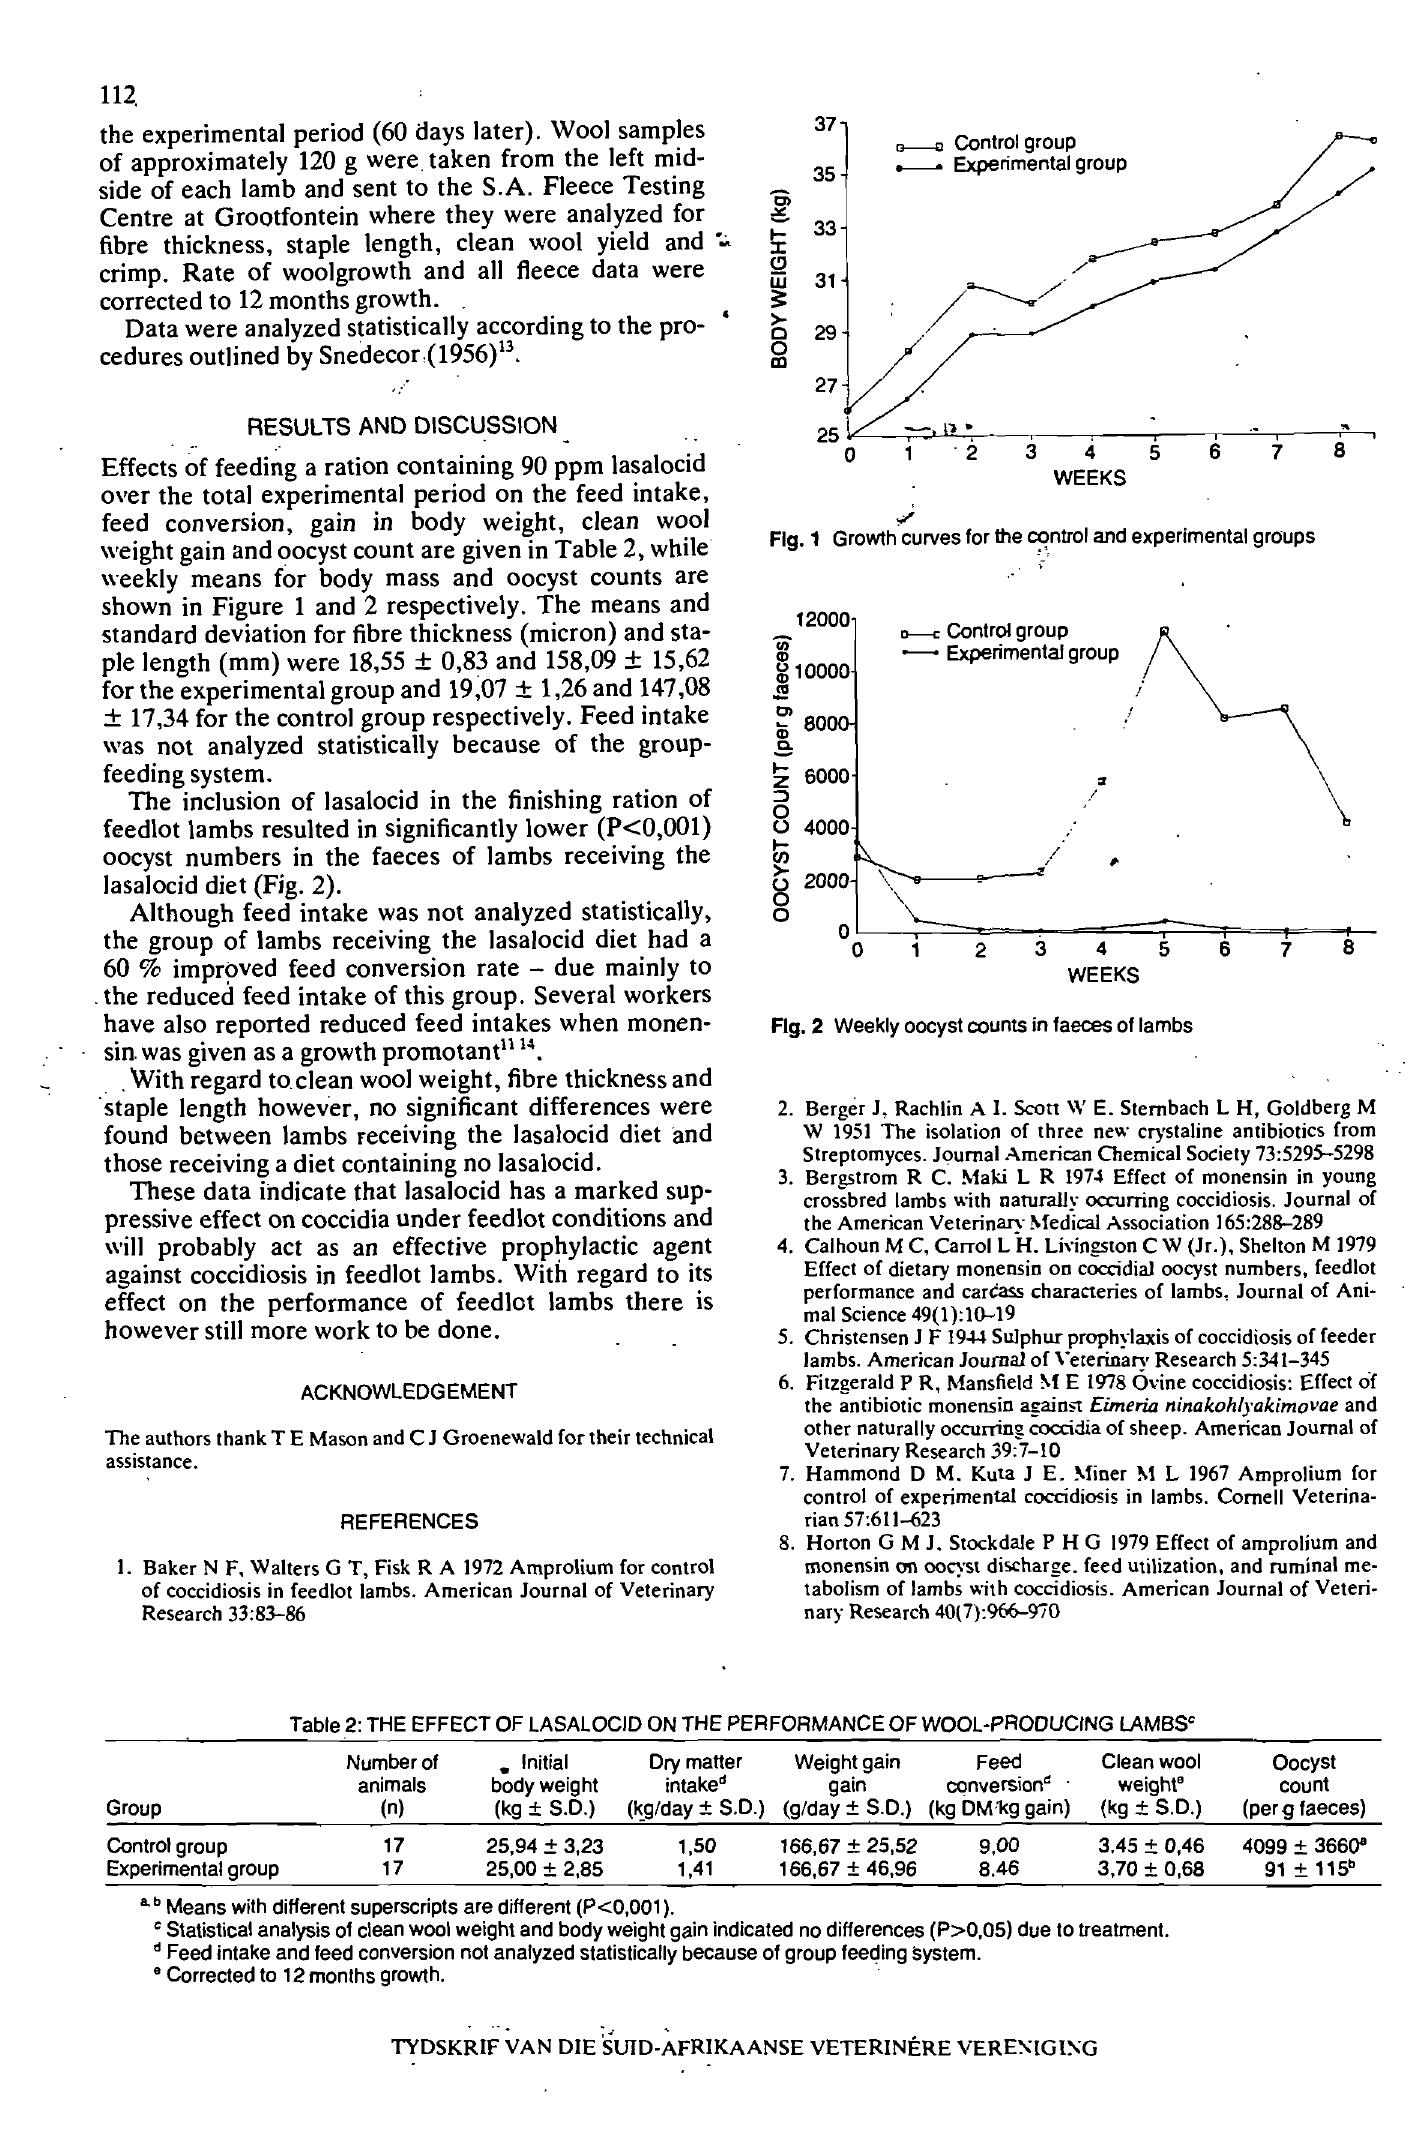
FIg. 2 Weekly oocyst counts in faeces of lambs